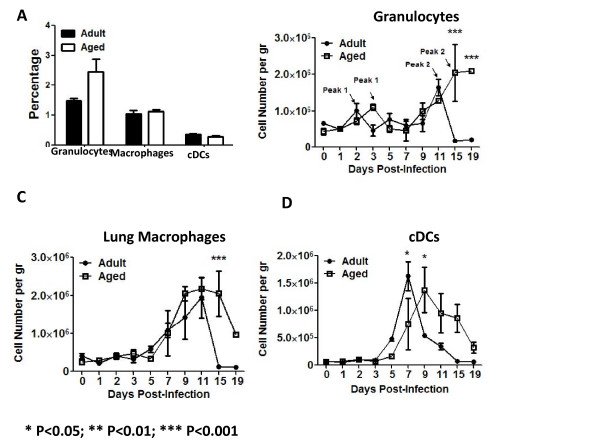
Innate Cells in the Lungs. Naïve mice (day 0) had no statistically significant differences in the innate populations analyzed by flow cytometry (A); however, aged animals had the tendency to have a higher percentage of granulocytes. There was a delay in the kinetics of granulocyte and cDCs infiltration in the lungs of aged mice (white squares) (B and D), which suggested alterations in chemokine production. Lung macrophages did not show altered infiltration kinetics, but cleared more quickly from the lungs of adult mice (black circles) (C), which correlated with a quicker recovery from adult mice. Stars indicate statistical difference between aged and naïve animals.*P < 0.05. **P < 0.01. ***P < 0.001.